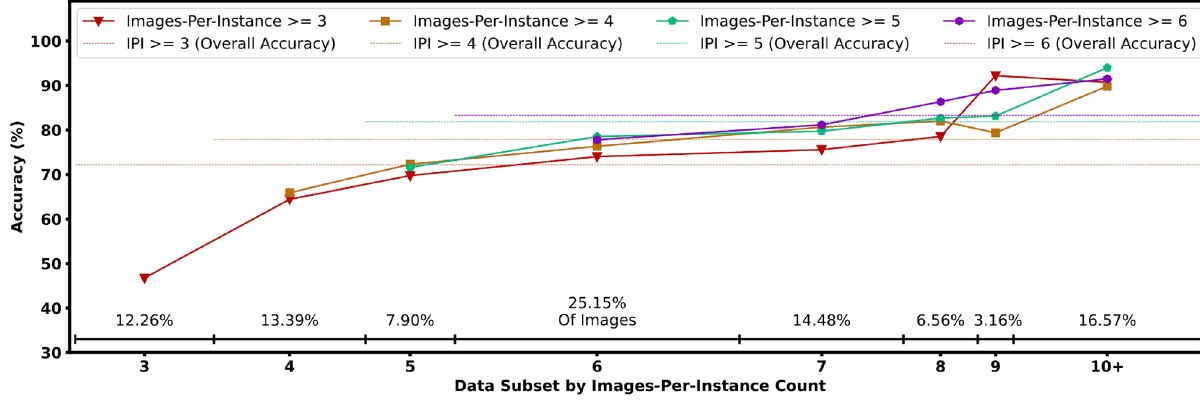
Figure 4. The accuracy of images of each subset by image-per-instance count for our best model (from Fig. 5) under each dataset makeup. For example, the triangular red plots indicate the object prediction accuracy of our highest performing model trained on the dataset with a minimum image-per-instance cutoff of three, further split by subsets of objects with exactly 3/4/5... images-per-instance. The dashed red line represents the overall accuracy, i.e. a weighted average of accuracies of each